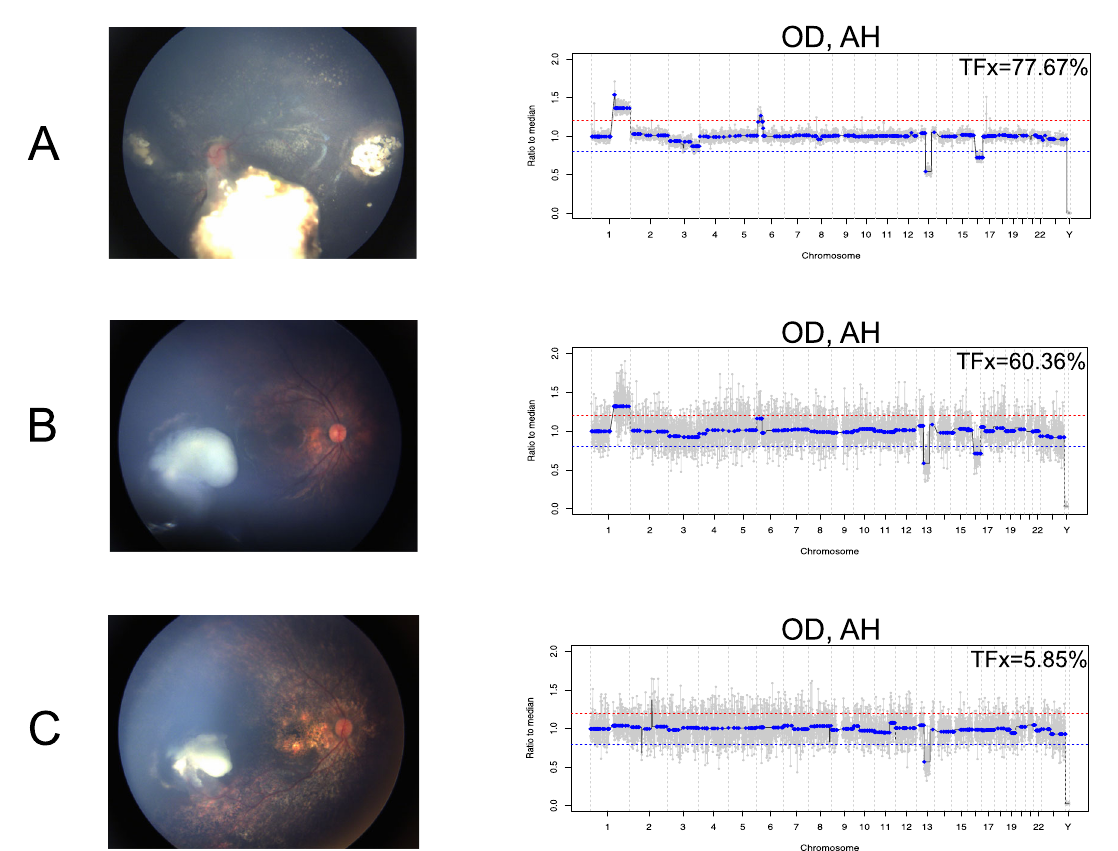
Fig. 2 Fundus photos of the right eye and matching genomic pro fi les from the aqueous humor (AH) obtained at the time of intravitreal melphalan (IVM) injections. In the right eye, tumor fraction (Tfx) steadily decreased over the course of 3 IVM injections ( A , B , and C ) and the TFx percentage calculated by ichorCNA is shown in the top of each genomic pro fi le. The decreases in TFx are accompanied by decreased amplitude of SCNAs, as expected, and decreased tumor burden shown in the matched fundus photos. Of note, the 13q deletion is a germline chromosomal alteration and its amplitude is not affected by decreased